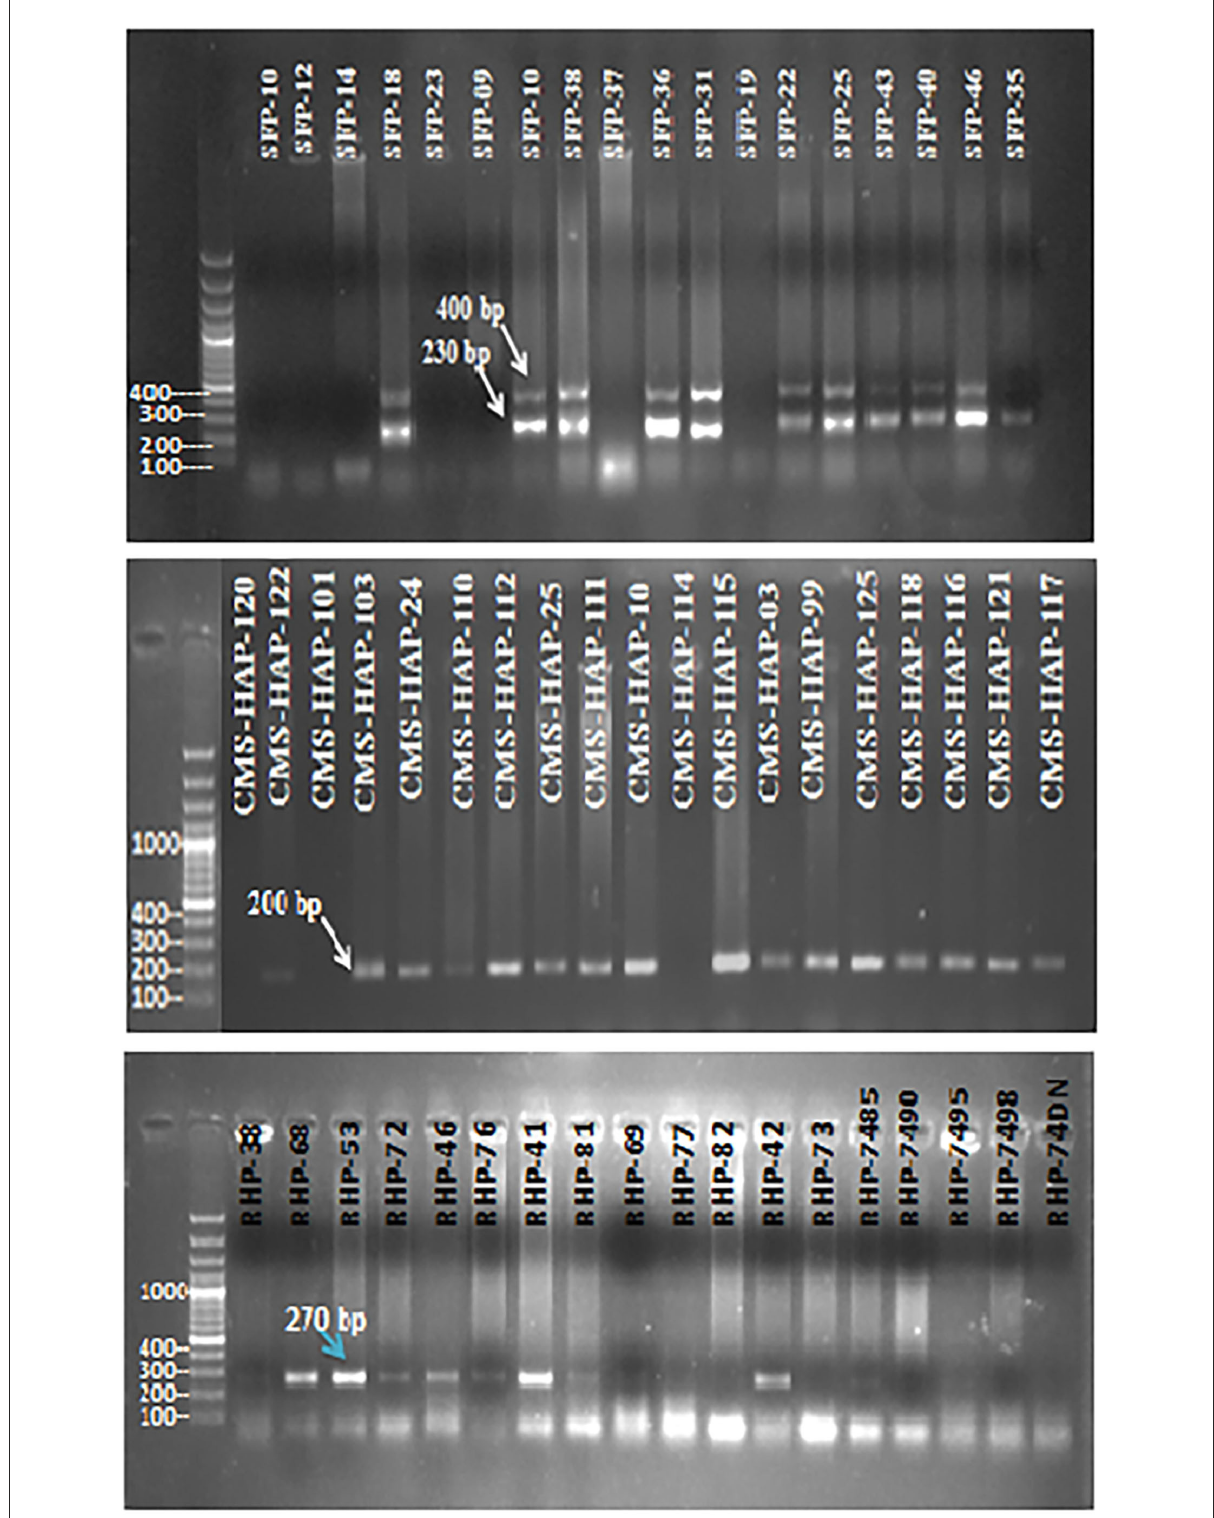
FIGURE4 Gel electropherogram of SSR marker (ORS-1024), (ORS-1085), and (ORS-613) for some sunflower